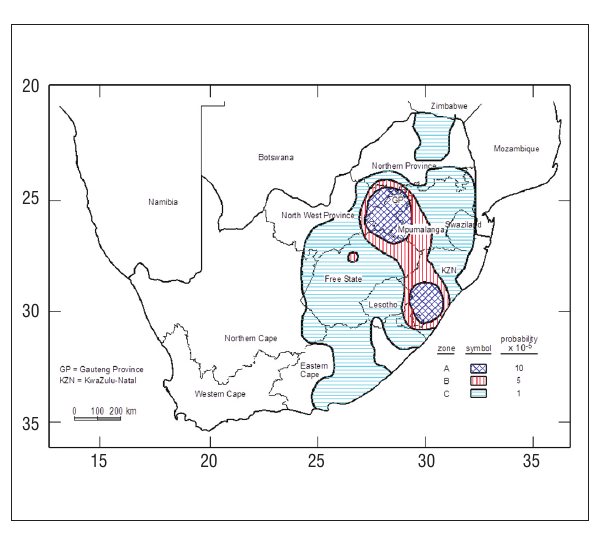
Figure 9: Mean rate of occurrence of tornadoes per annum, excluding tornadoes of intensity F0 as analysed by Goliger et al .